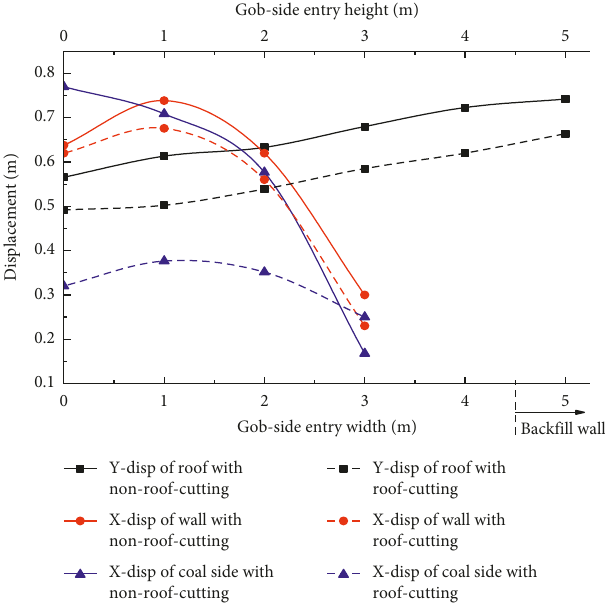
Figure 13: Displacement variations of surrounding rocks of the roadway with roof cutting or